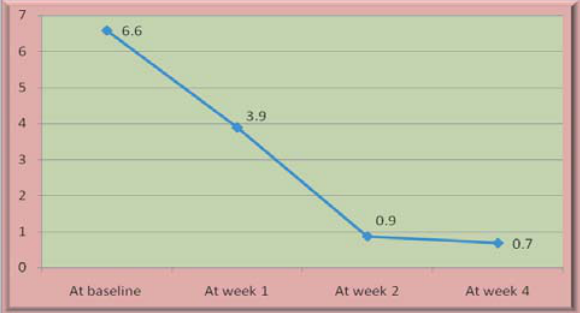
Fig 2. Clinical assessment score at different intervals